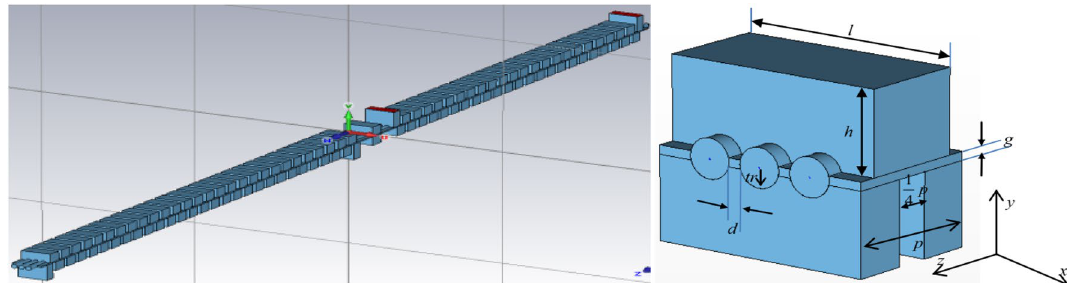
Figure 1. Schematic of W-band three-beam staggered double-vane TWT with the single period of the